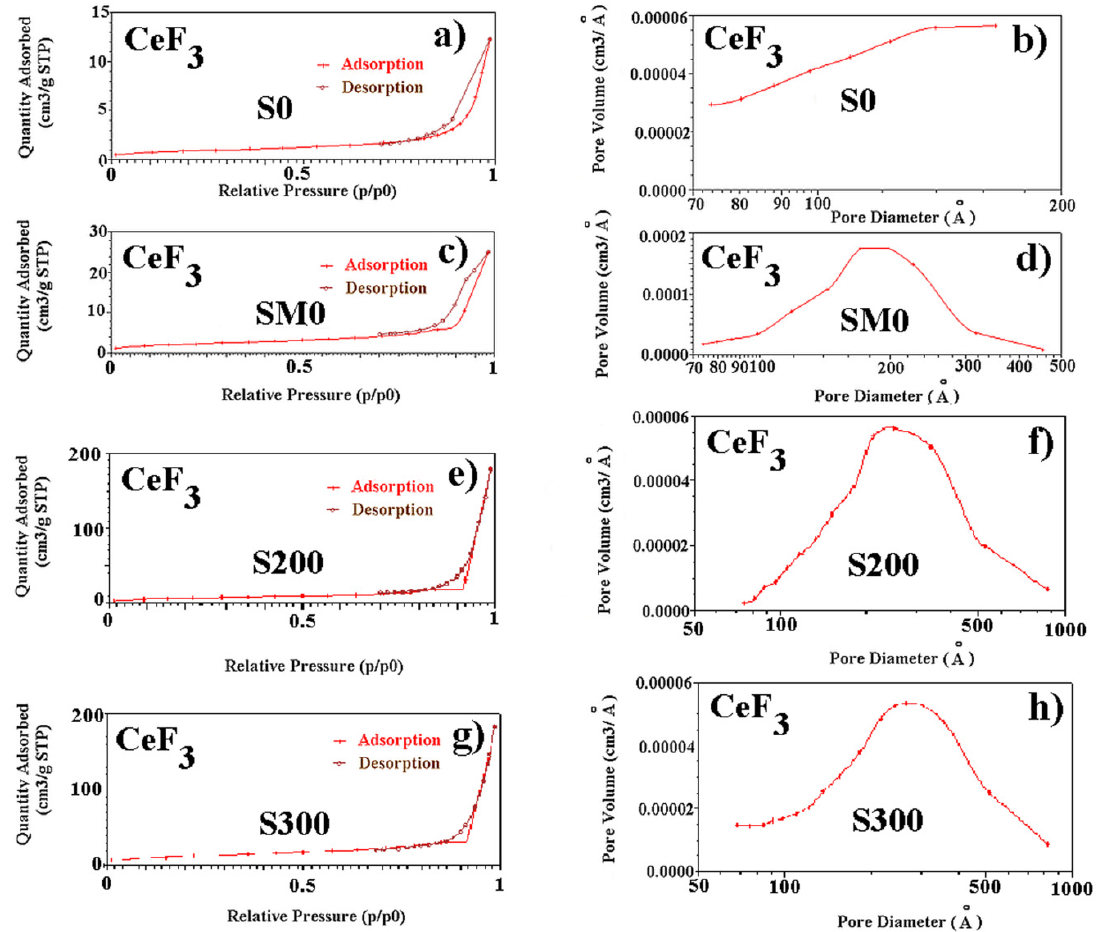
Figure 4. Nitrogen adsorption/desorption isotherms ( a , e , g ) and pore-size distribution curves ( b , f , h ) of samples S0, S200, S300 and commercial micron powder Ce F 3 ( c , d ), respectively. Table 3. Texture parameters of non-annealed and air-annealed samples of CeF 3 micro and nano powders.